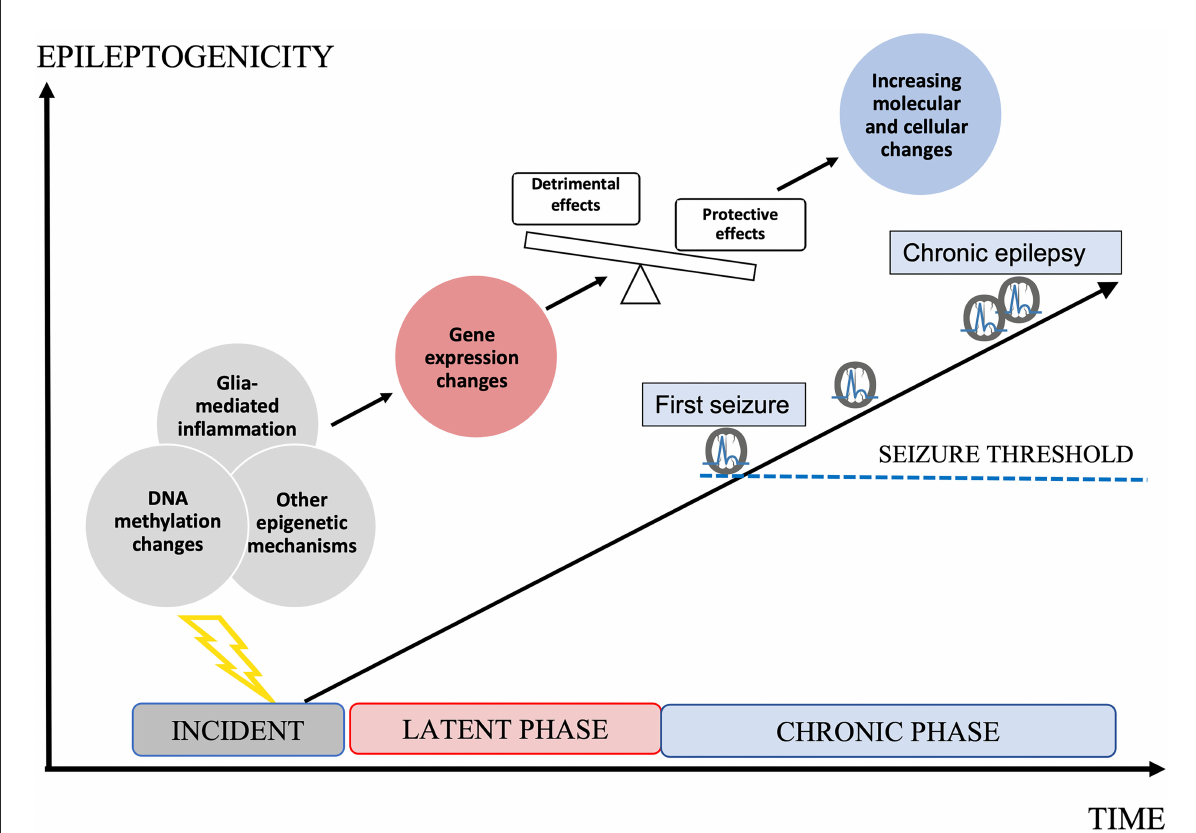
FIGURE1 Epileptogenesis. Epileptogenesis describes the development of a brain becoming prone to generate epileptic seizures and further progression. An initial incident occurs to the brain, initiating the latent phase in which molecular and cellular changes increasingly develop. Epigenetic mechanisms, such as DNA methylation (DNAm) changes may determine changes in gene expression (GE) and by this cellular responses in both neurons and glial cells. Both protective and detrimental changes occur. Imbalance in favor to detrimental effects leads to increasing epileptogenicity up to the threshold of clinical seizures. During the chronic phase, epileptogenicity increases leading to the progression of clinical epilepsy, accompanied by increasing molecular and cellular changes. Both the latent phase and the chronic phase could be relevant to the development of anti-epileptogenic